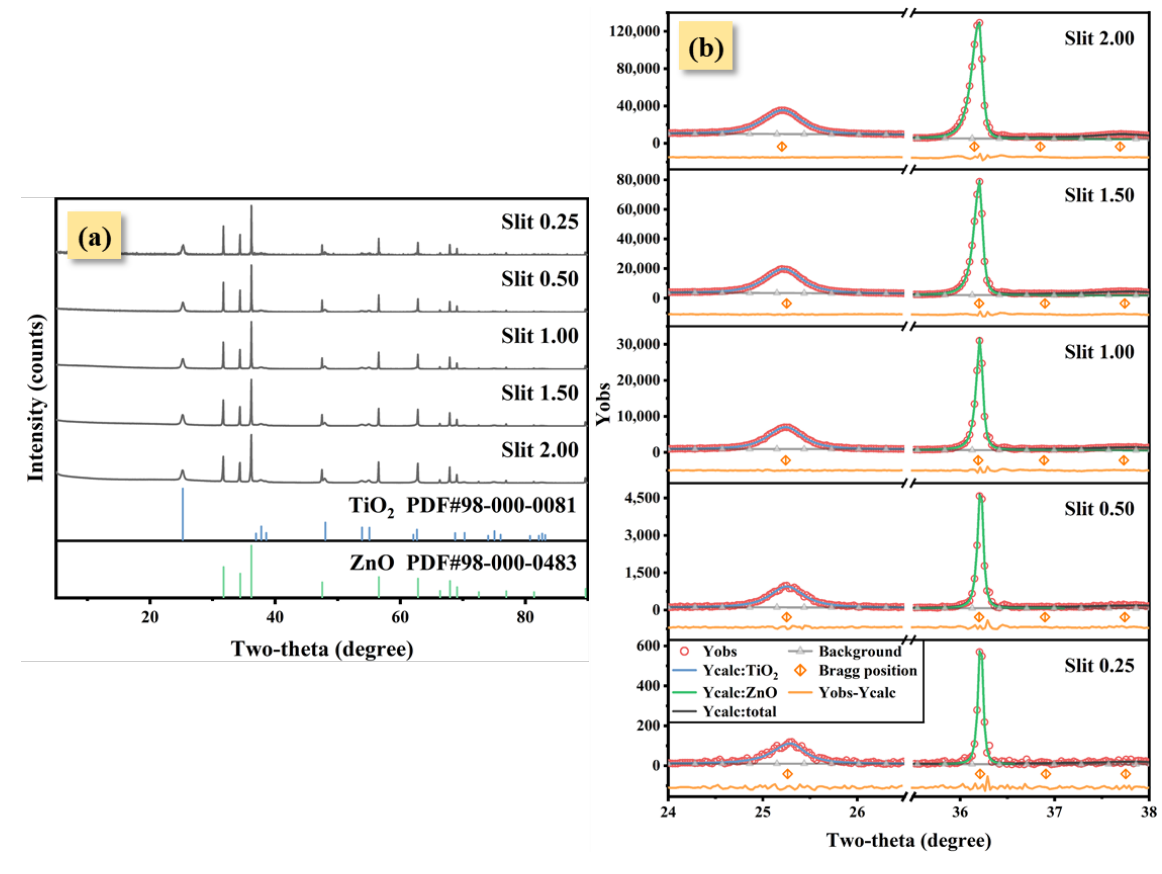
Figure 4. TiO 2 -ZnO (1:1)’s XRD patterns under five cross-slit widths ( a ). The strongest peaks of nano-TiO 2 and ZnO were fitted using PVF to obtain peak shape parameters ( b ). Table 3. TiO 2 -ZnO (1:1)’s peak shape parameters and quantitative results of RIR method under different cross-slit